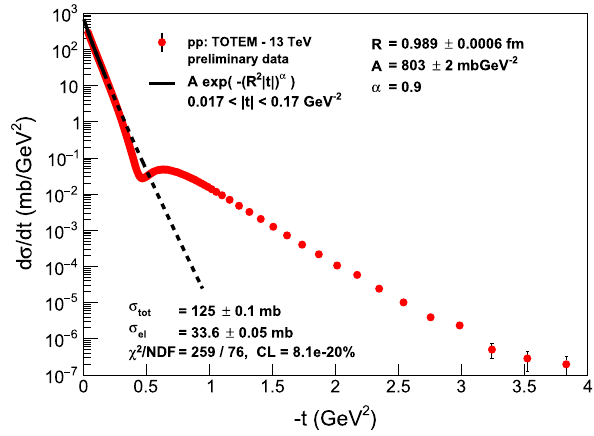
Fig. 42 Zeroth-order Lévy fits to the cone region of the differential cross-section data on pp elastic scattering at preliminary), with fixed α = 0 . 9, A and R being free fit